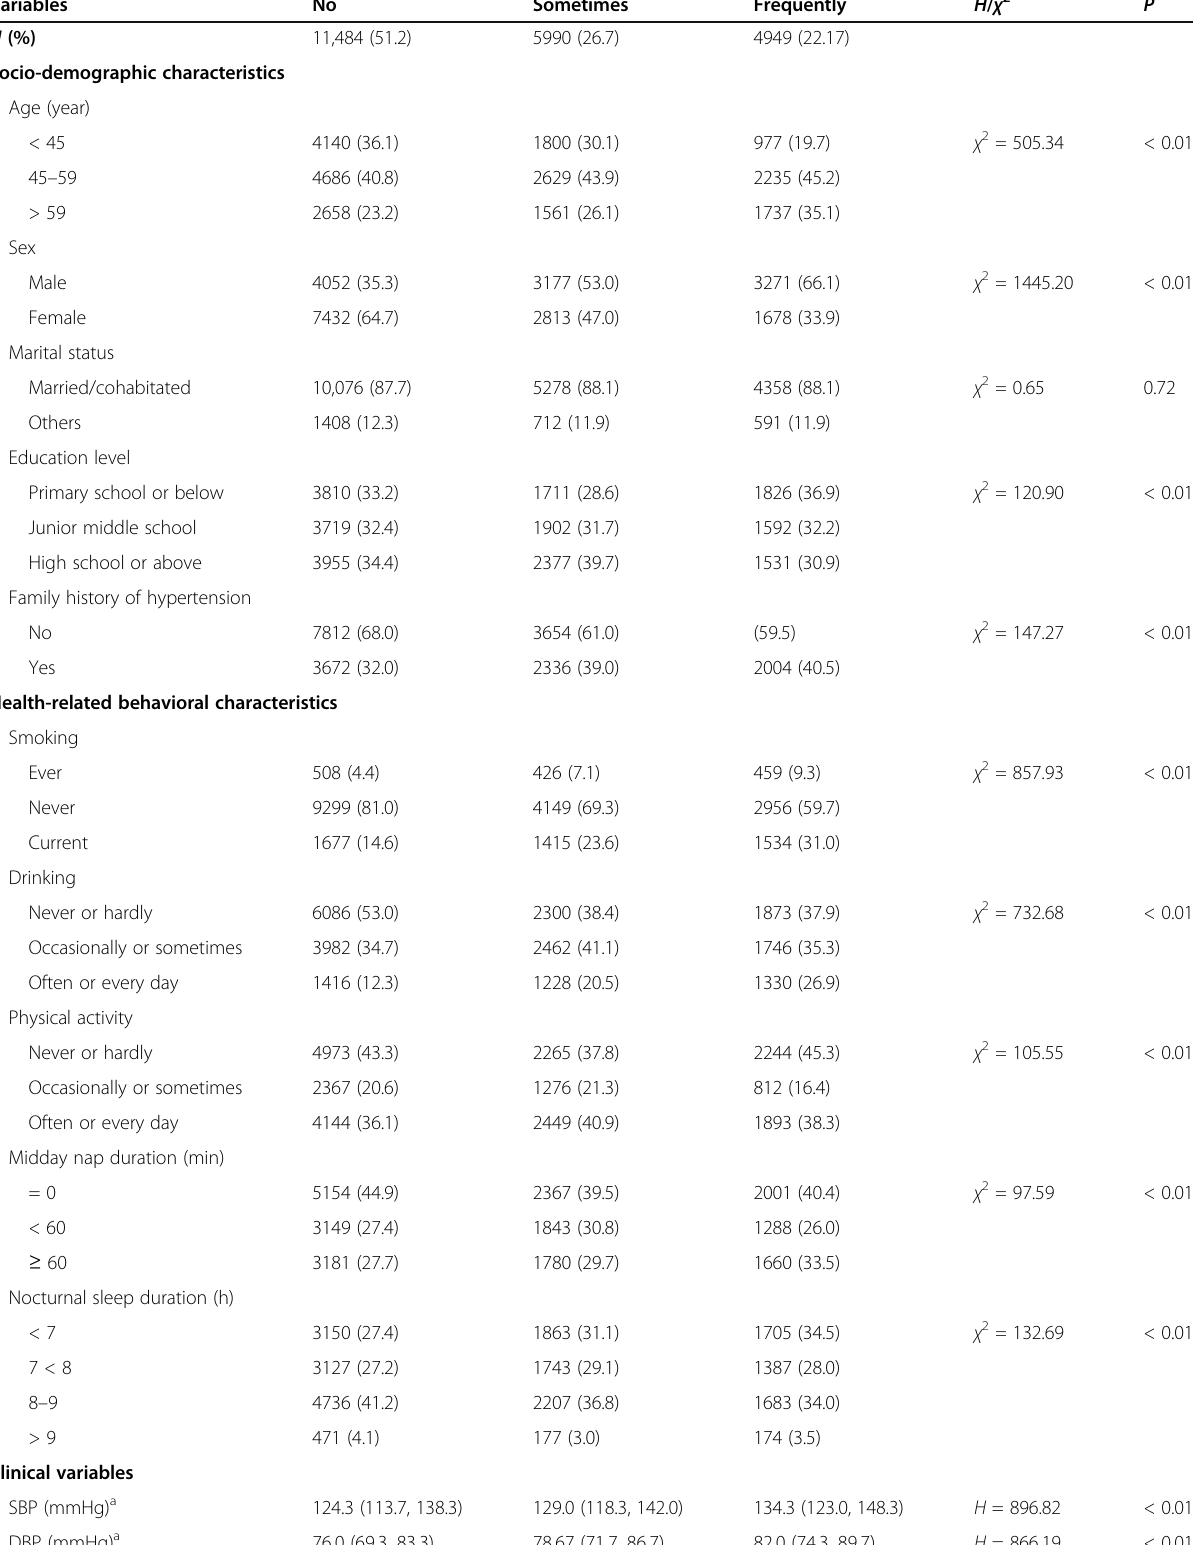
Table 1 Characteristics of participants by groups of self-reported